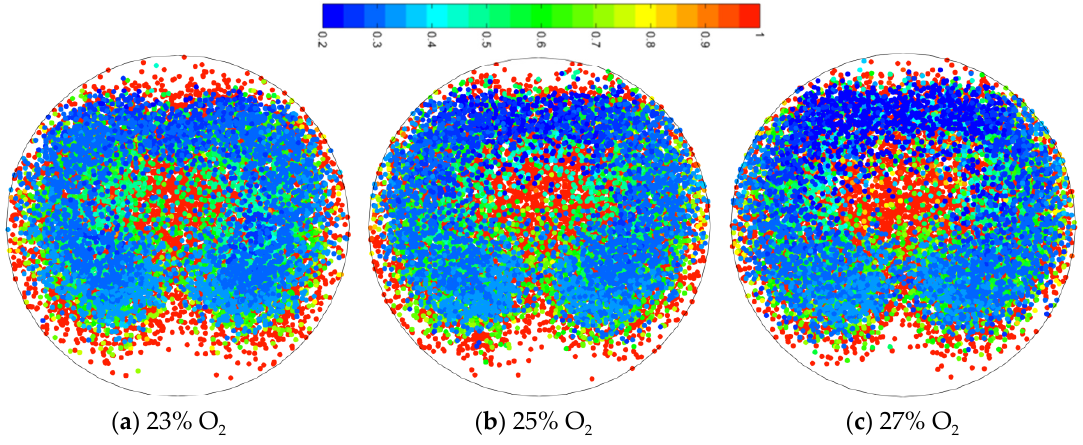
Figure 9. Coal particles combustion characteristics under targeted oxygen-enrichment.